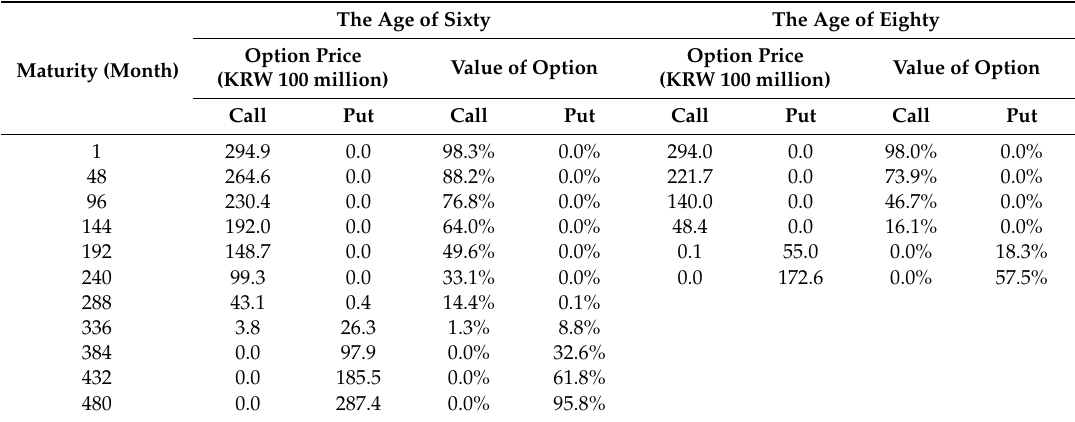
Table 7. Sensitivity analysis of the change of maturity. This table presents the estimated total option value based on changes in maturity.